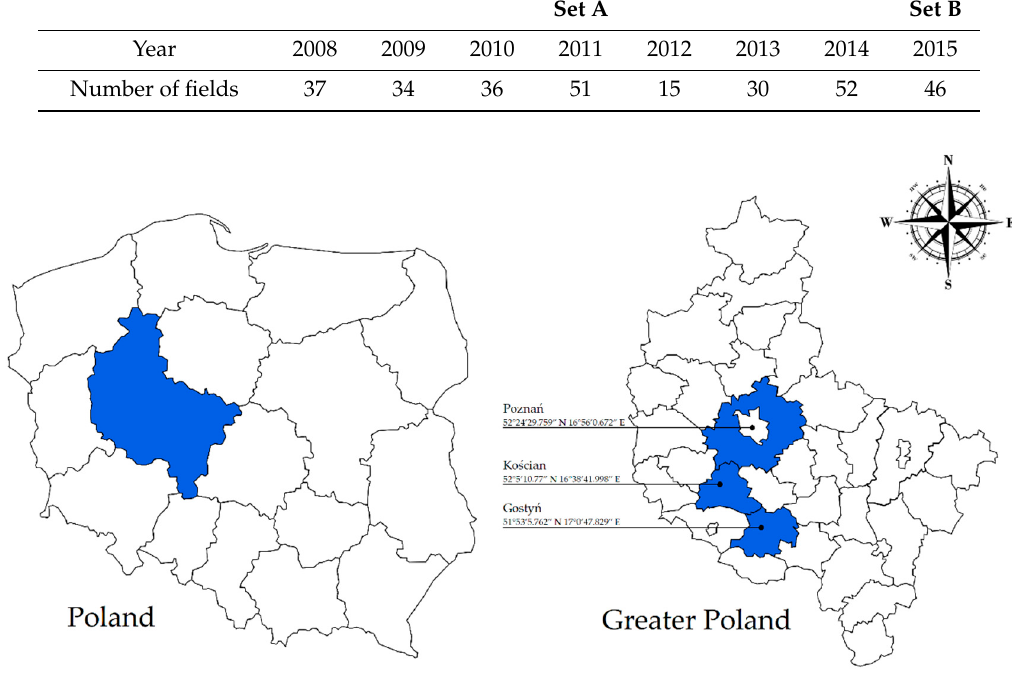
Table 2. Data structure in neural prediction models.